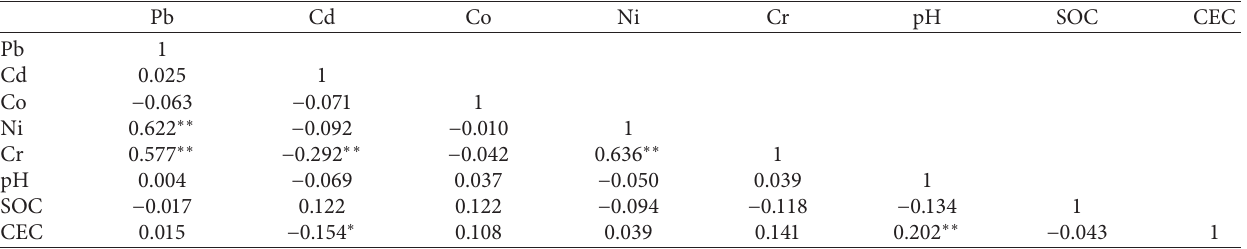
Table 2: Pearson correlation coefficients of heavy metal concentrations in the soil of shallot fields in Brebes Regency, Central Java, Indonesia.